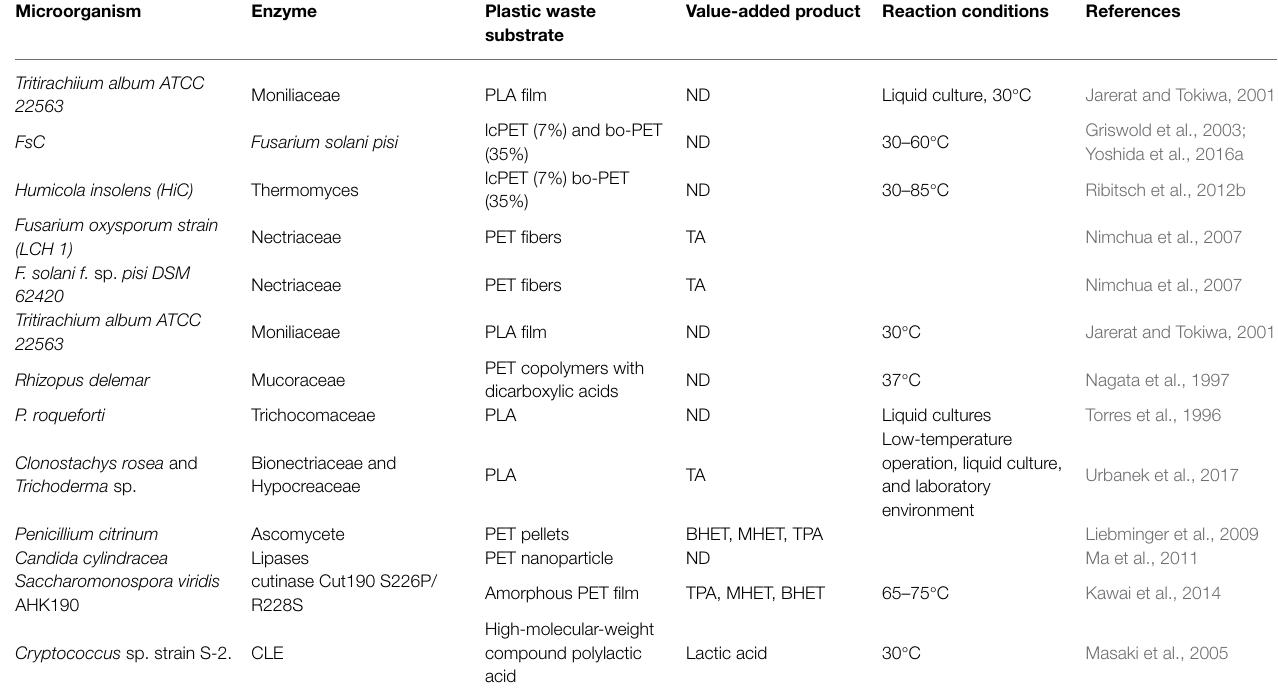
TABLE 3 | Plastic biodegradation using different enzymes derived from fungi.